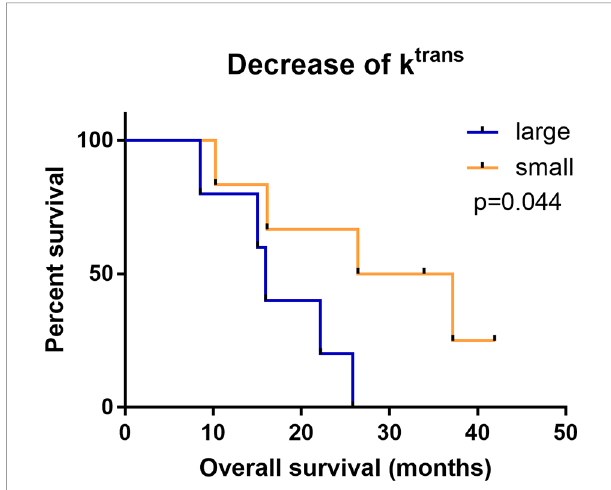
FIGURE 4 | Kaplan-Meier analysis of OS comparing groups with a large (red) and small (blue) change in the K trans